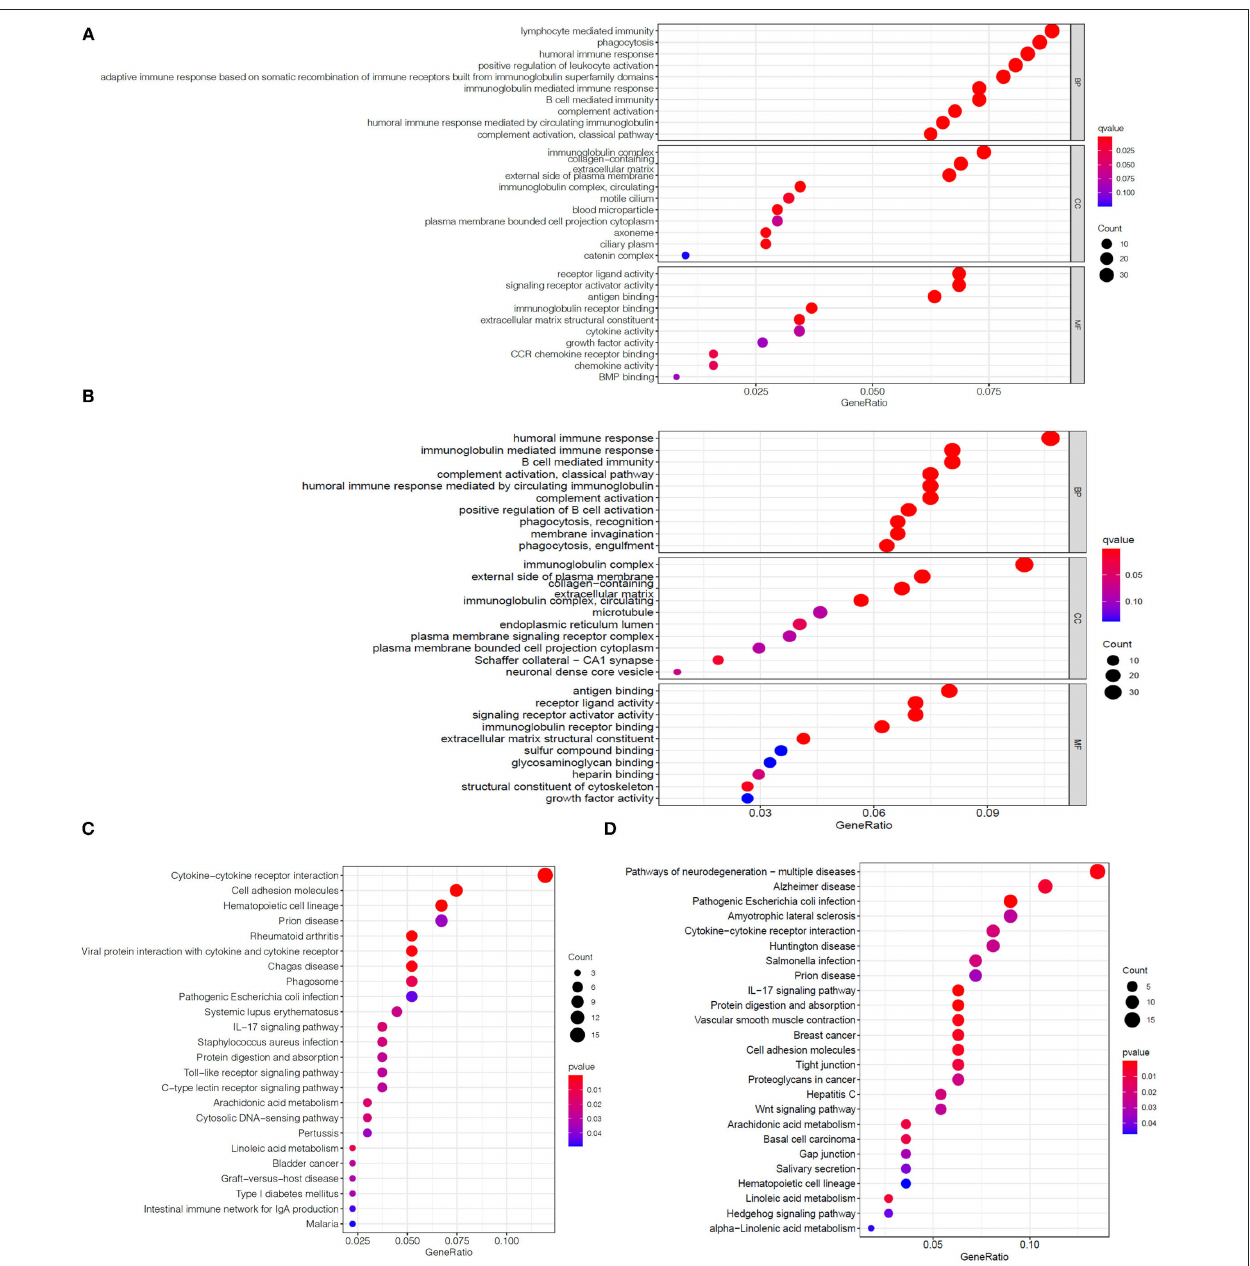
FIGURE 5 | Enrichment analysis of DEGs between two risk groups. Bubble graphs of GO enrichment analysis of DEGs in the TCGA training set (A) and the TCGA validation set (B) . Bubble graphs of KEGG pathway enrichment analysis of DEGs in the TCGA training set (C) and the TCGA validation set (D) .